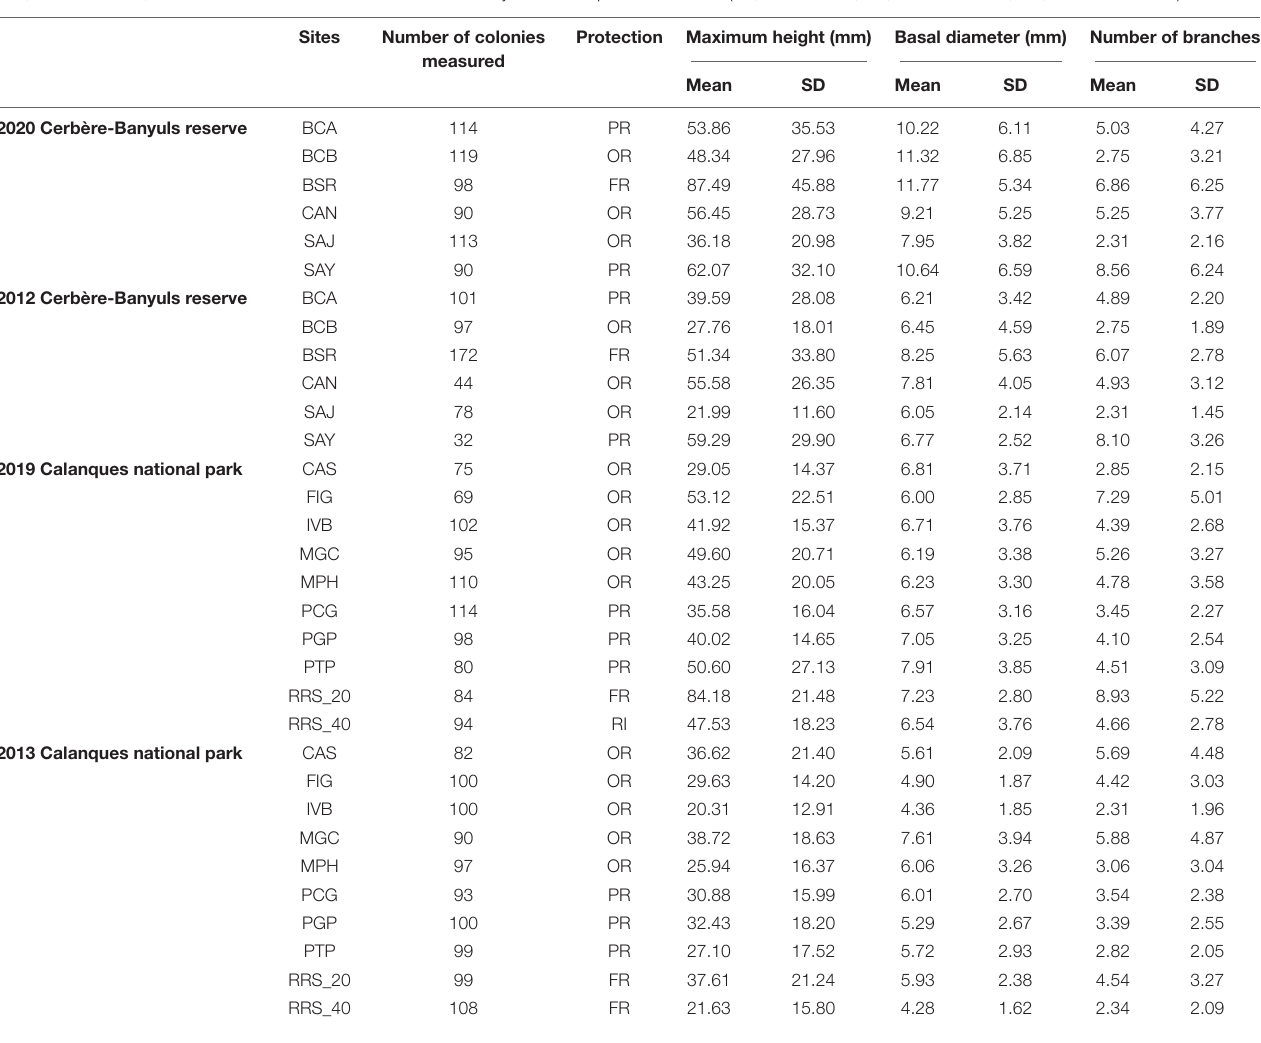
TABLE 2 | Number of colonies measured, mean and standard deviation of each metric for each site of Cerbère-Banyuls reserve and Calanques national park: maximum size, basal diameter, and number of branches for each site of each year in each protection status (FR, Full Reserve; PR, Partial Reserve; OR, Outside Reserve).